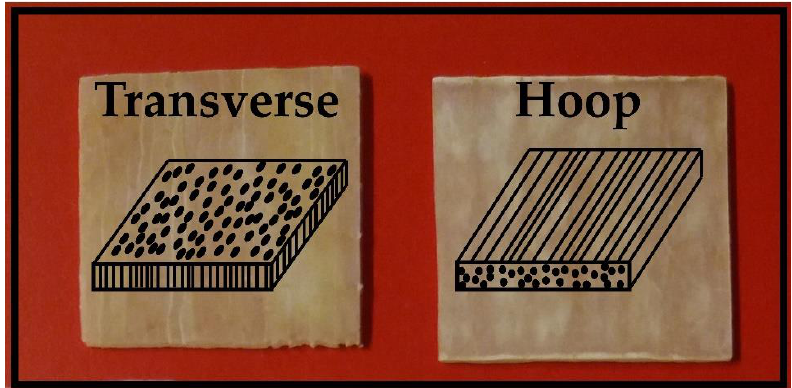
Figure 2. GFRP plate specimen fiber orientations: ( left ) transverse and ( right ) hoop orientations.